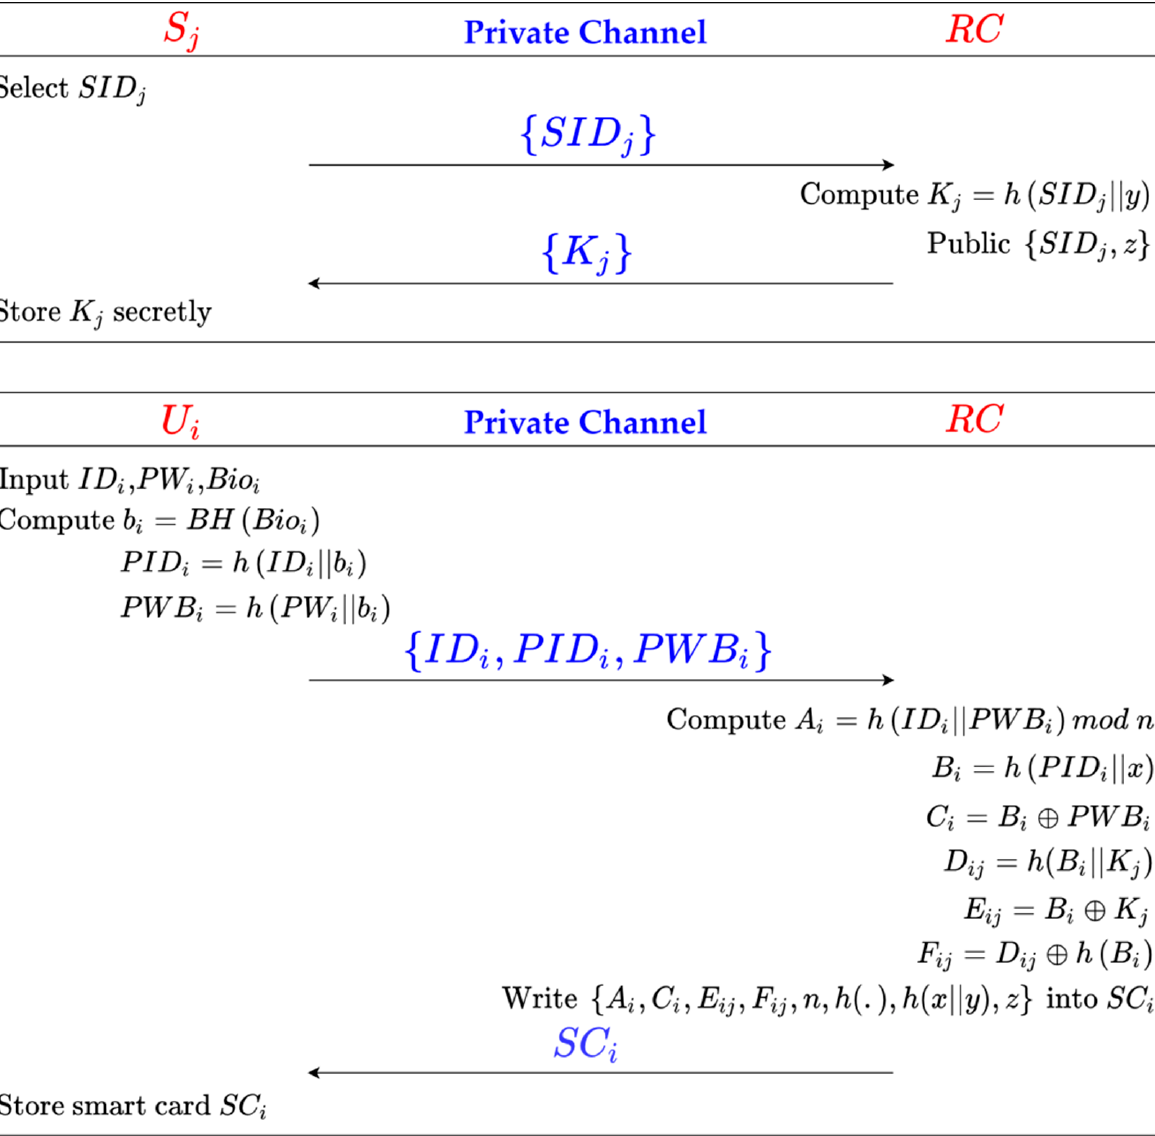
Figure 4. Registration phase of proposed scheme.